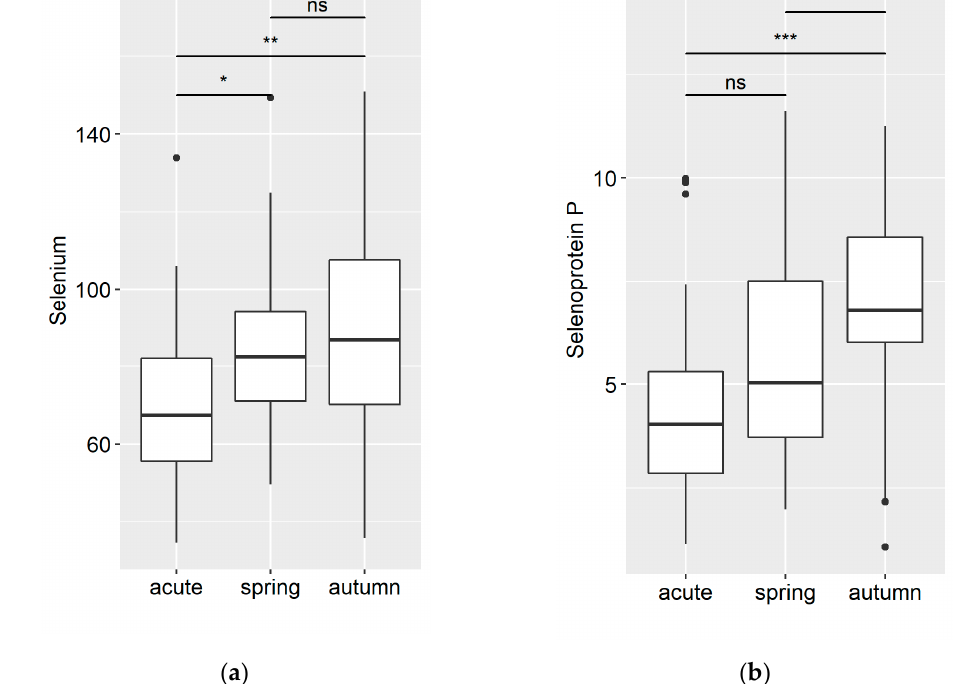
Figure 1. ( a ) Se concentrations, μ g/L, and ( b ) Sepp1 concentrations, mg/mL, in blood plasma of acutely ill COVID-19 patients (acute) and in post-COVID-19 disease patients 2 months following their discharge from the hospital: infected with COVID-19 in the spring–early summer period (spring) or in summer–autumn period (autumn). Black dots show not significant outliers. * p < 0.05; ** p < 0.01; *** p < 0.001;